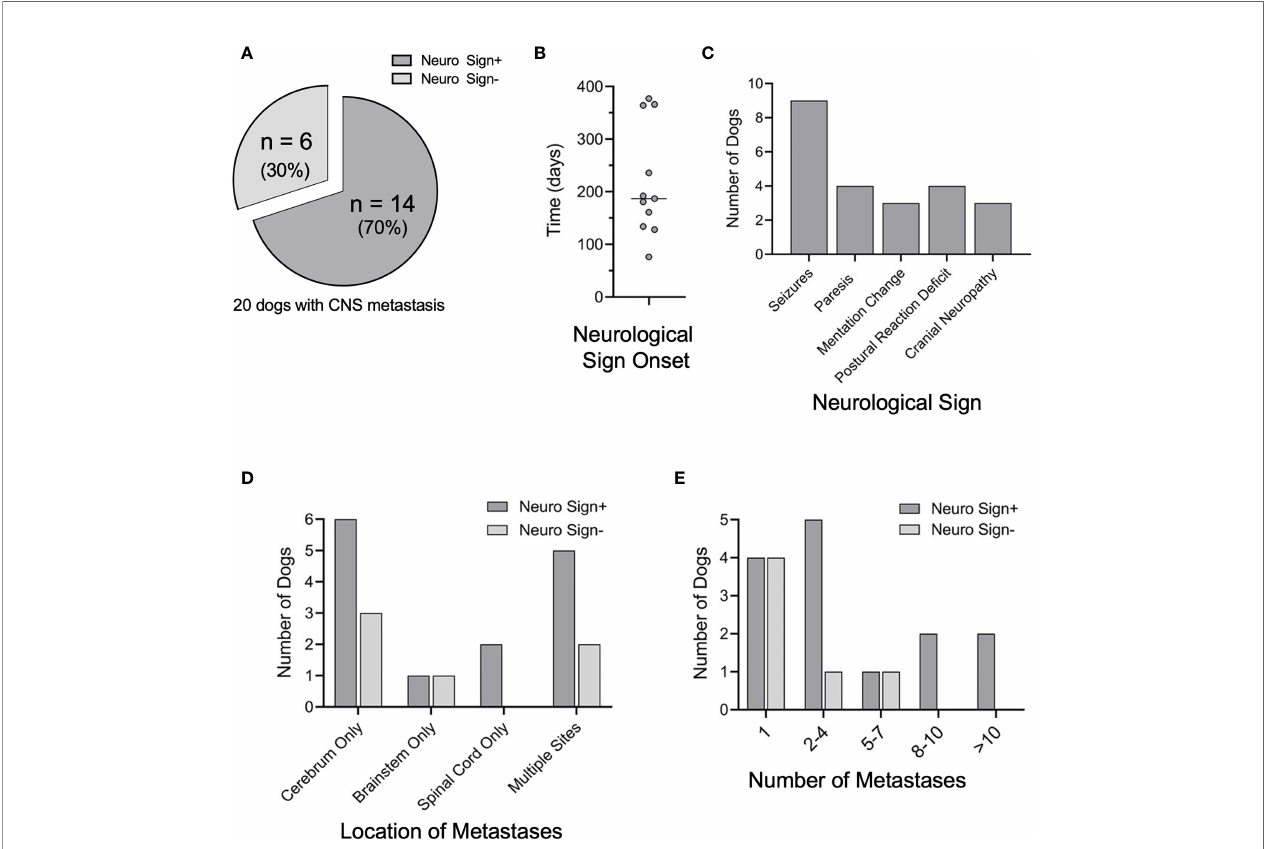
FIGURE 4 | Neurological signs and CNS disease burden. (A) Of the 20 CNS+ dogs, 14 developed neurological signs prior to humane euthanasia or death. (B) Elapsed time between the initial diagnosis of melanoma and the onset of neurologic signs (n=11). (C) Of those that developed neurological signs, the most common initial sign noted was seizures, followed by paresis, postural reaction de fi cits, mentation change, and cranial nerve neuropathy. (D) Although location of CNS metastases varied among CNS+ dogs, the cerebrum was the most common site of metastases. Location of metastases were similar between dogs with and without neurological signs (cerebrum p=0.642; brainstem p=0.521, spinal cord p=0.999). (E) The number of CNS metastases between dogs with and without neurological signs was not different (1, p=0.161; 2-4, p=0.613; 5-7, p=0.521; 8-10 and > 10, p= 0.999). Comparisons were made by two-tailed Fisher ’ s Exact tests.